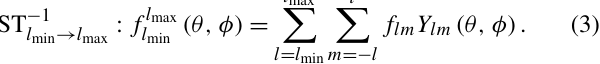
Figure 4. Ensemble mean (a) , standard deviation (b) of the prior ensemble and true anomaly (c) for the SSH (in metres), after extrac- tion of the large scales ( l ∈ [0 ; l c ], with l c = 34, which corresponds to a characteristic scale larger than L ≈ 187km; see Eq.